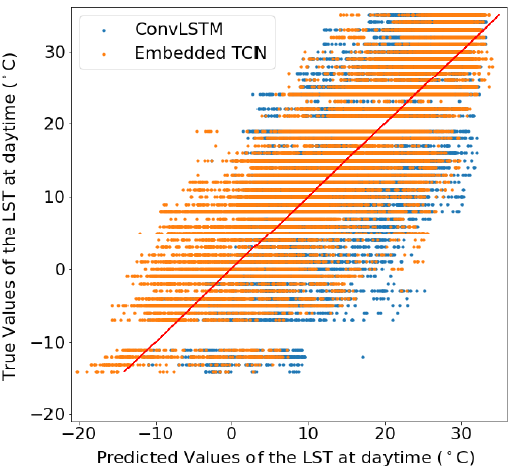
Figure 10. LST scatter plot for 140 × 140